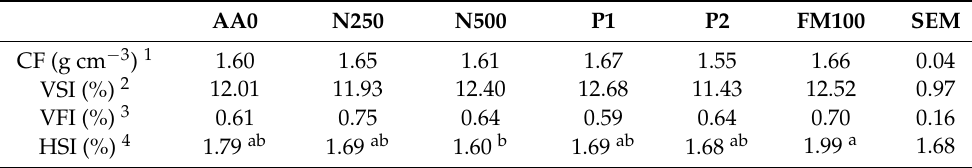
Table 4. Biometric indices of seabream fed with different experimental diets.